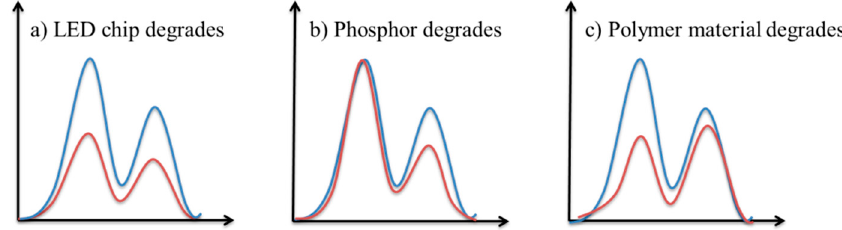
Figure 6. Failure mechanism classification in a pc-WLED package (the blue and red curves represent the initial and aged SPDs, respectively).